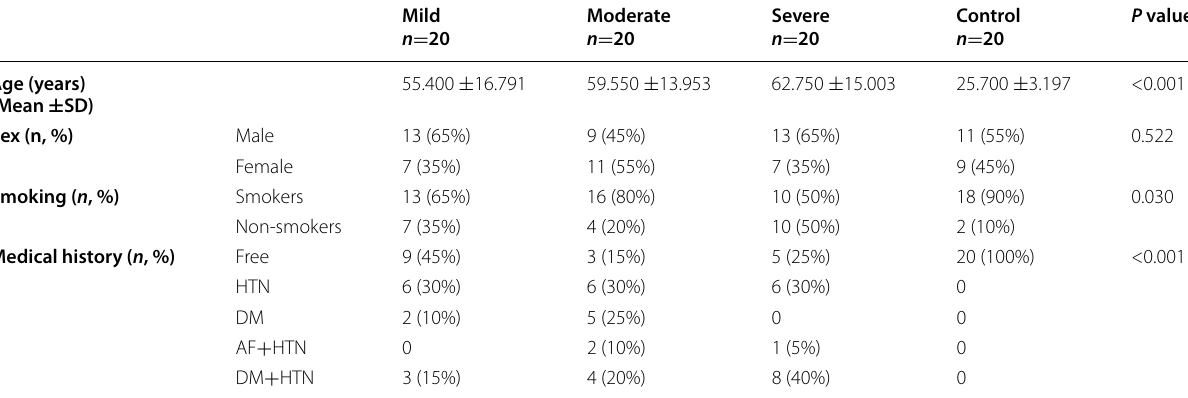
Table 1 Demographic data of patient groups with mild, moderate, and severe COVID-19 manifestations and control